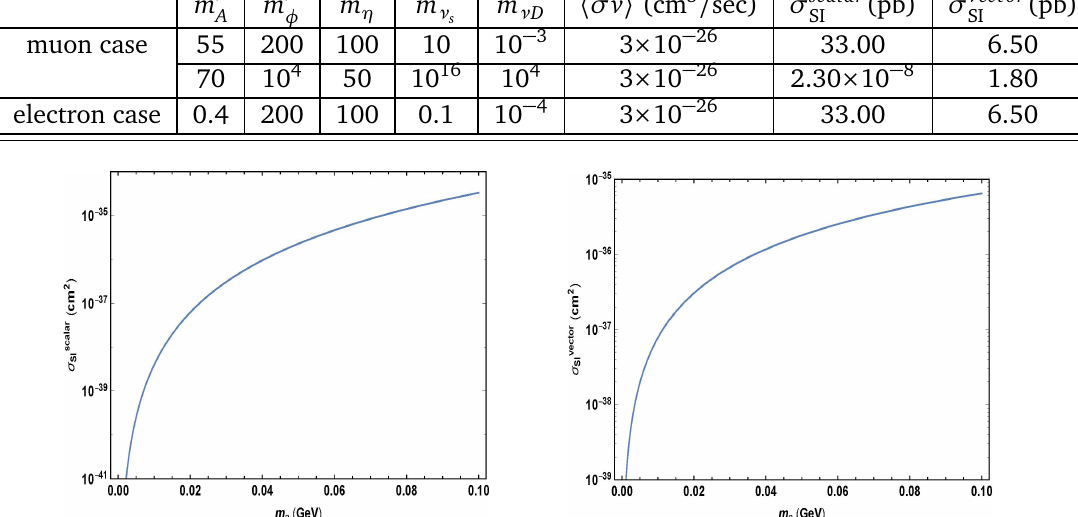
Figure 13.2: Dark matter-nucleon scattering cross section as a function of the dark matter mass. The cross sections are calculated for m φ (cid:48) = 100 MeV, δ = 0 and V = 10 GeV. These dark matter-nucleon cross sections are allowed by CRESST III, XENON1T and CDEX-1B